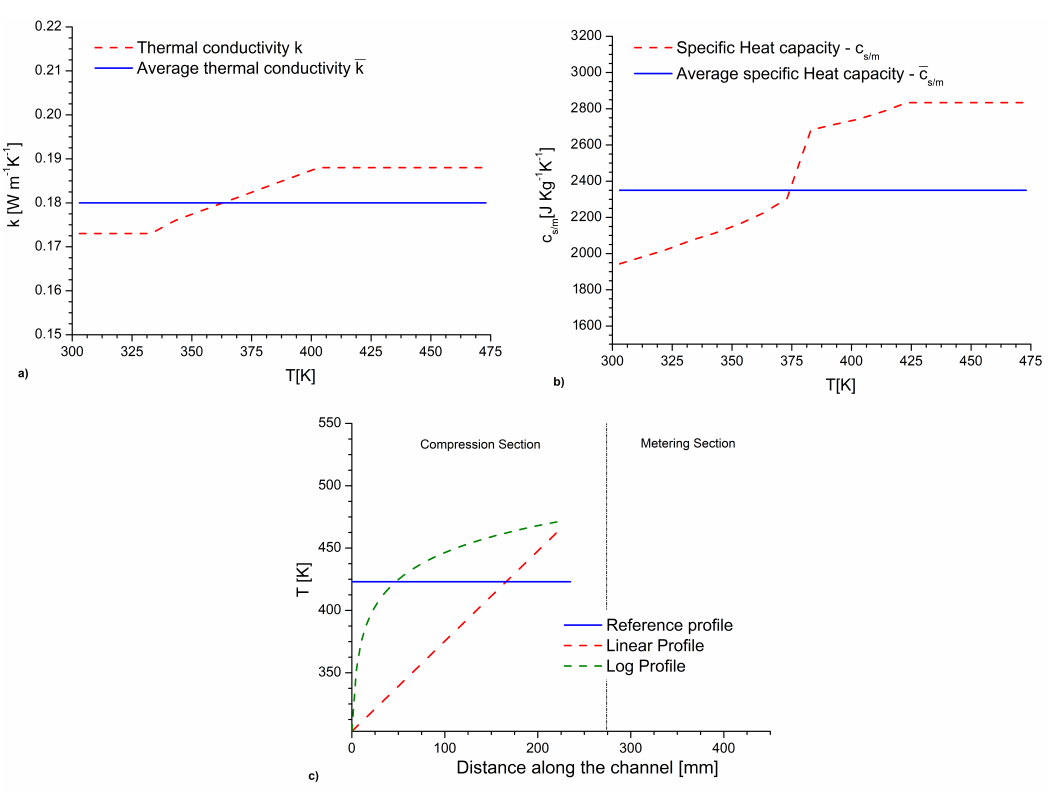
Figure 13. Variations of ( a ) the thermal conductivity and ( b ) specific heat capacities due to the temperature dependencies in ( c ), also displaying in blue the micro-extrusion reference case results in Table 1 with constant thermochemical properties (423 K